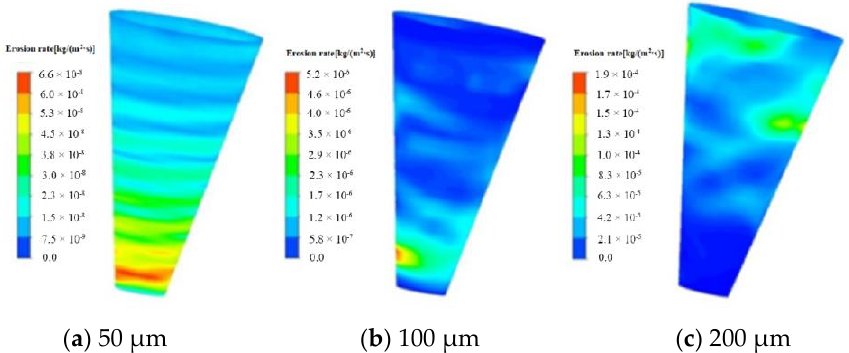
Figure 10. Location of the cone erosion for different particle diameters (50, 100, 200 μm) .